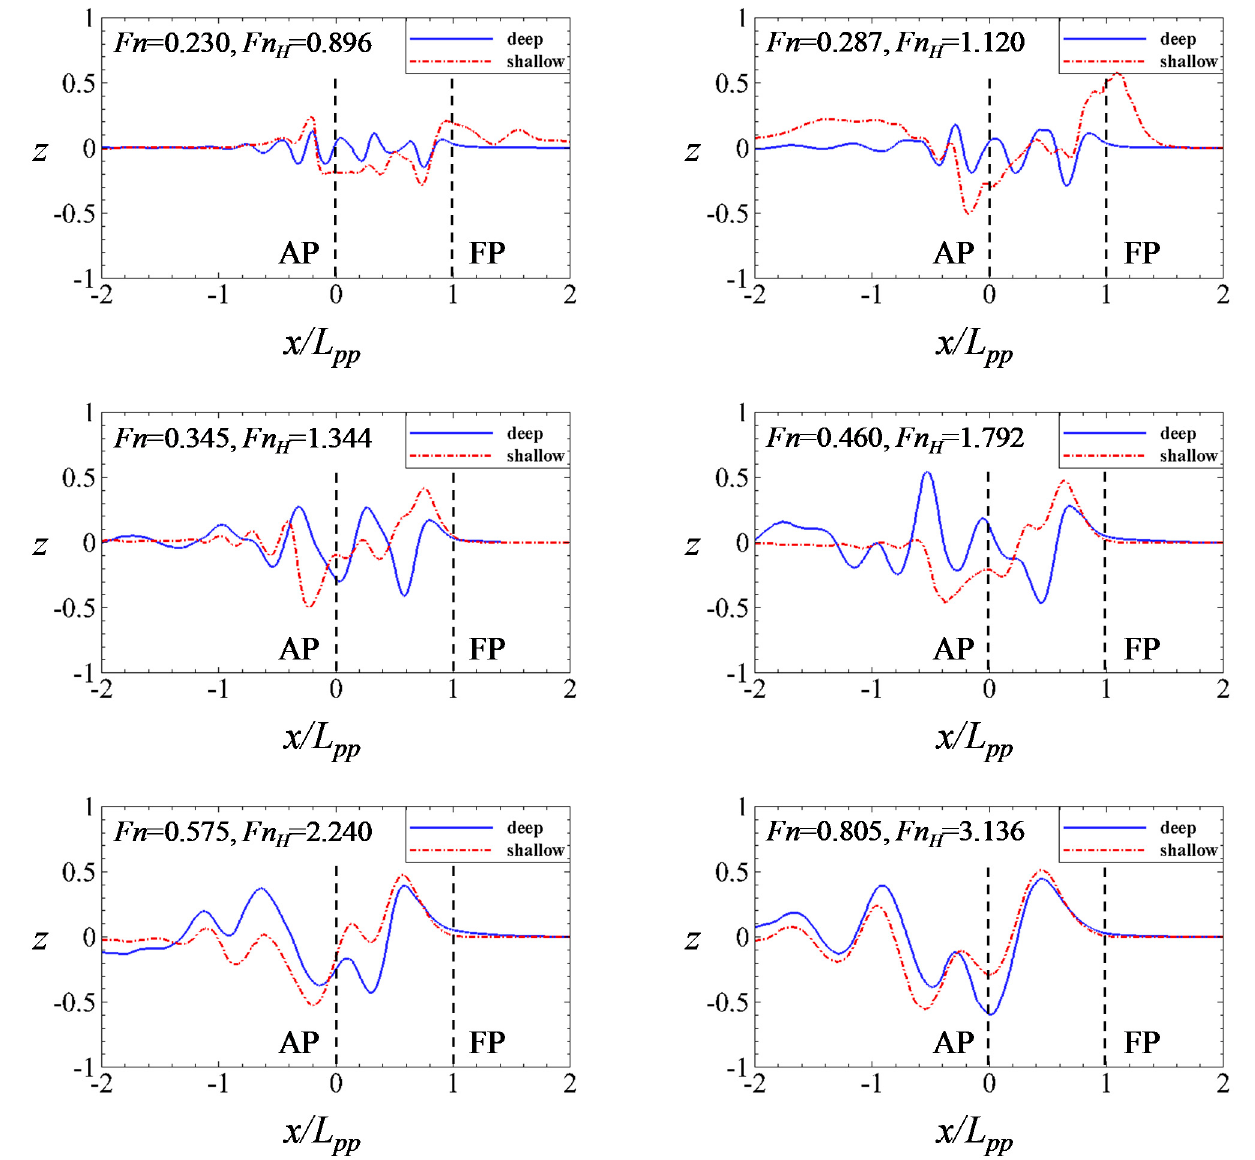
Figure 16. Comparison of the longitudinal wave cuts at the catamaran symmetry plane in deep and shallow water.